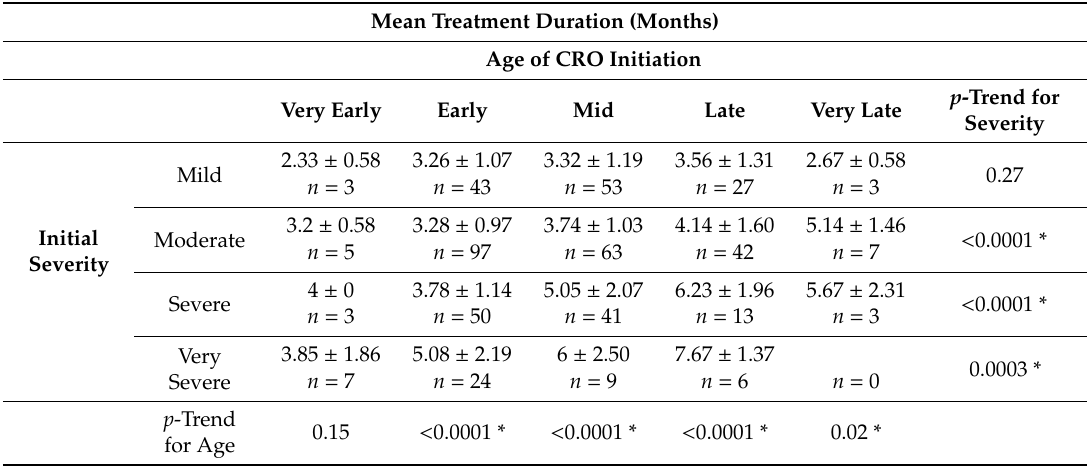
Table 3. Mean treatment durations ± standard deviations for each age and severity subgroup ( n = 499).